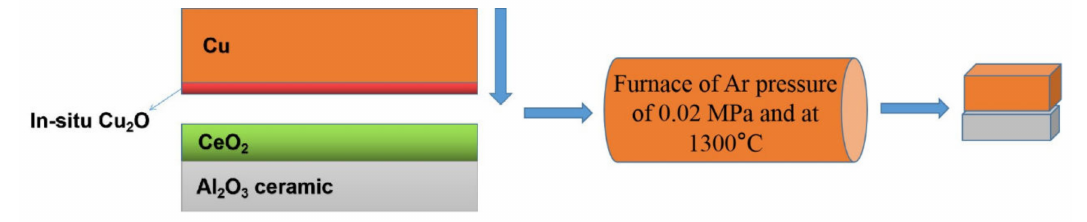
Figure 1. Sketch of experimental